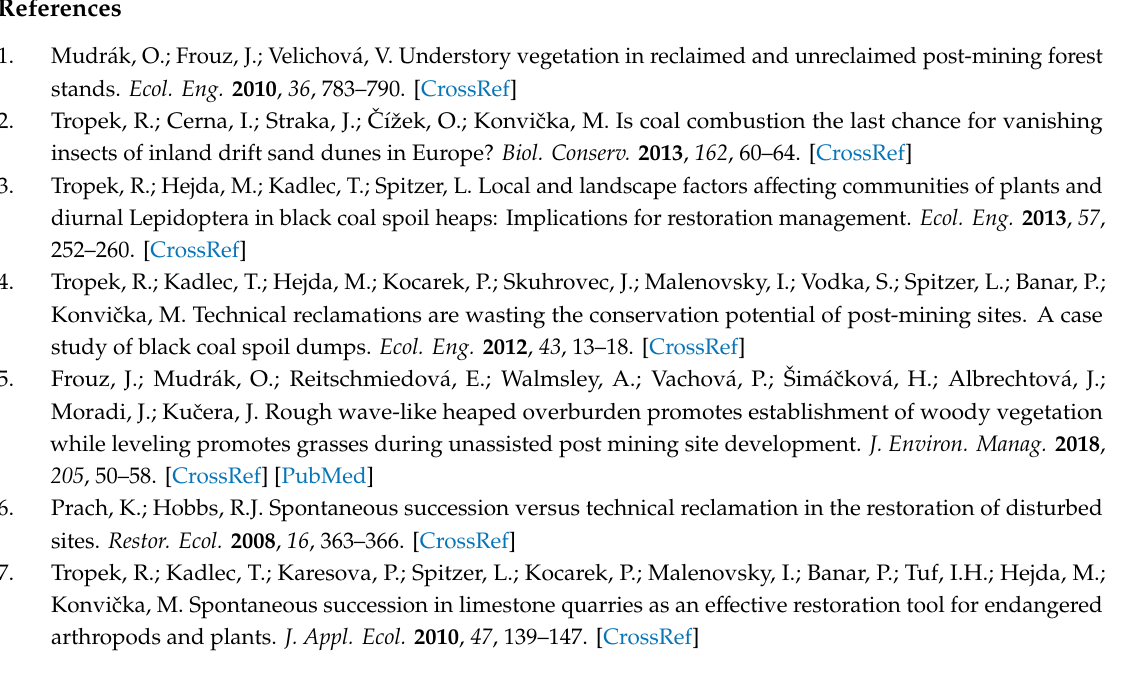
Figure S1 examples freshly dumped post mining site (a), and older site with wave like surface (b) and flat site Table S2 Percentage of cover of dominant woody species, in individual sites, C means control forest outside mining site. Table S3 Presence and absence of individual species of Diplopoda, Isopoda, Chilopoda and Lumbricidae, C means control forest outside post mining